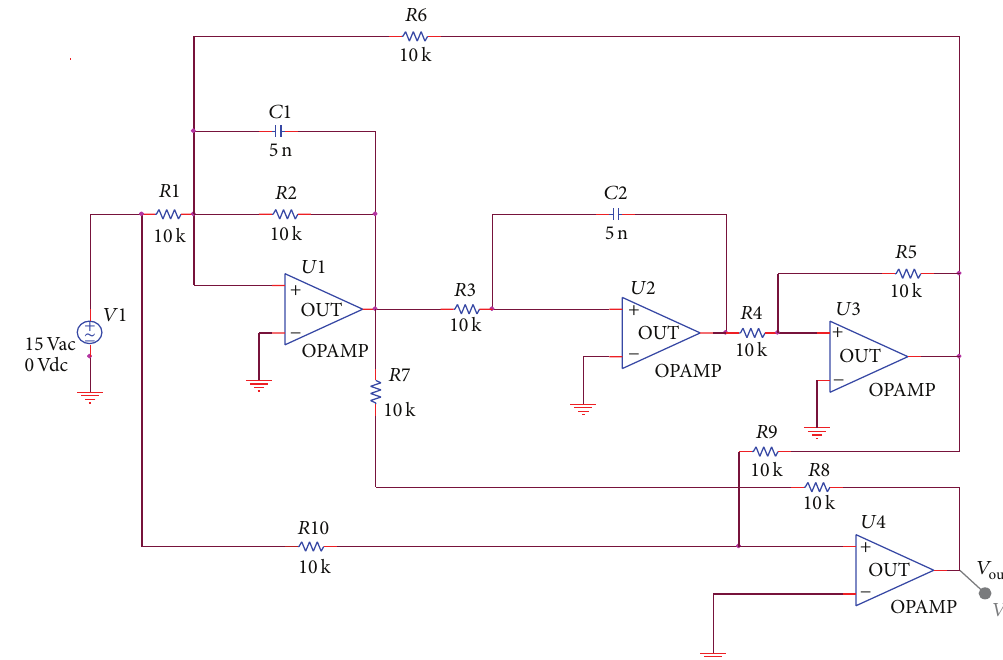
Figure 11: Four-op-amp biquad low-pass filter